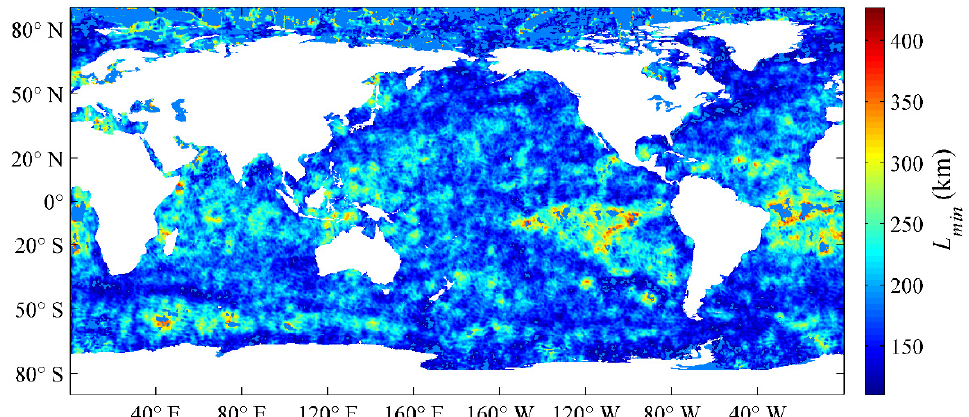
Figure 2. Global distribution of the L min parameter estimated using the optimum interpolation (OI) analysis results of Figure 2. Global distribution of the 𝐿 (cid:3040)(cid:3036)(cid:3041) parameter estimated using the optimum interpolation (OI) analysis 2015 results of 2015 [13]. Figure 2. Global distribution of the 𝐿 (cid:3040)(cid:3036)(cid:3041) parameter estimated using the optimum interpolation (OI) analysis results of 2015 [13].